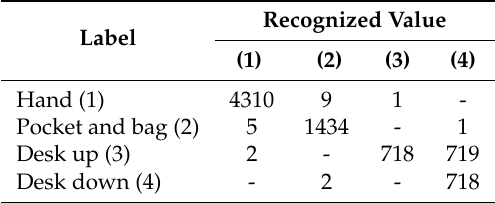
Table 5. Confusion matrix associated to phone status recognition.